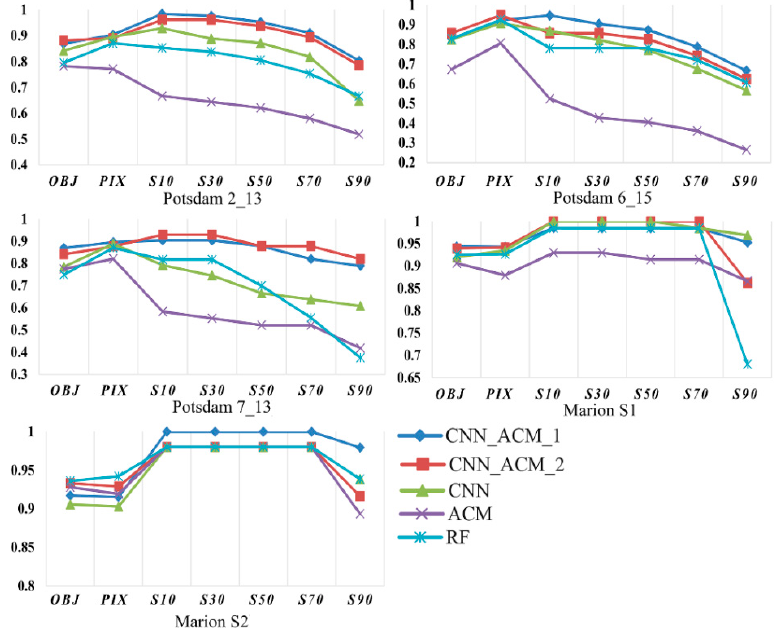
Figure 10. Assessments using the two datasets are compared for the building boundary extraction methods, including the proposed methods, CNN, RF, and ACM. The abbreviation of OBJ denotes results at the object level, the abbreviation of PIX for pixel-based assessment, S10 for scene-based assessment with the overlapping threshold of 10%, and so on.